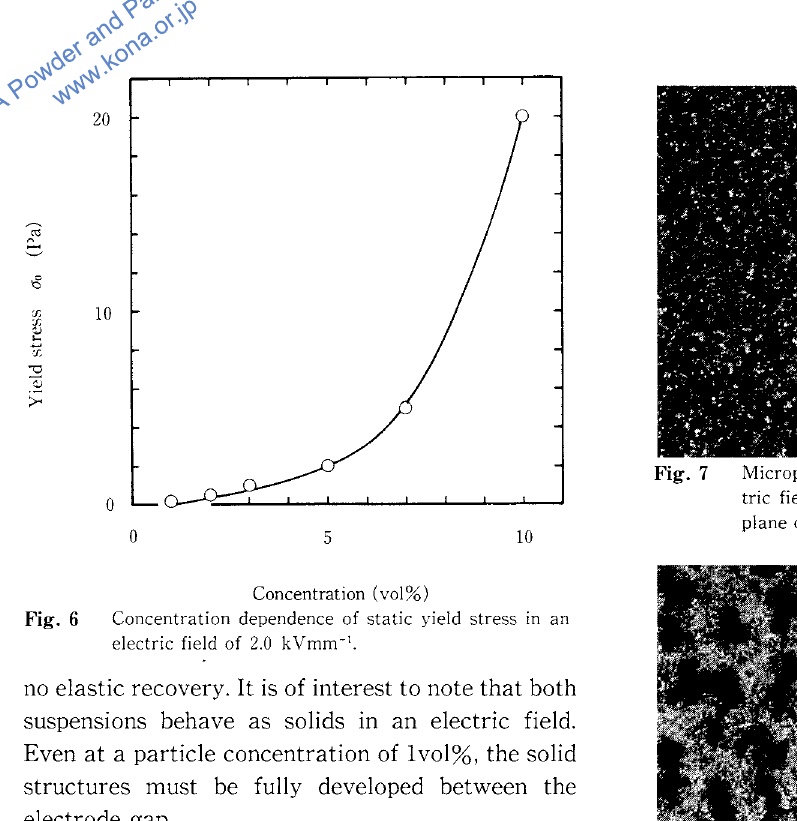
Fig. 8 Microphotograph of 7 vol% suspension in an electric field of 2.0 kVmm-'. The electric field is perpendicu lar to the plane of the